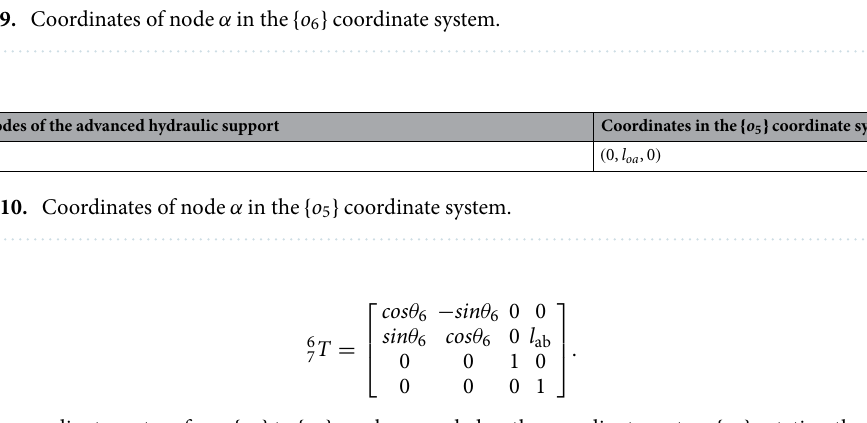
Table 9. Coordinates of node α in the { o 6 } coordinate system.